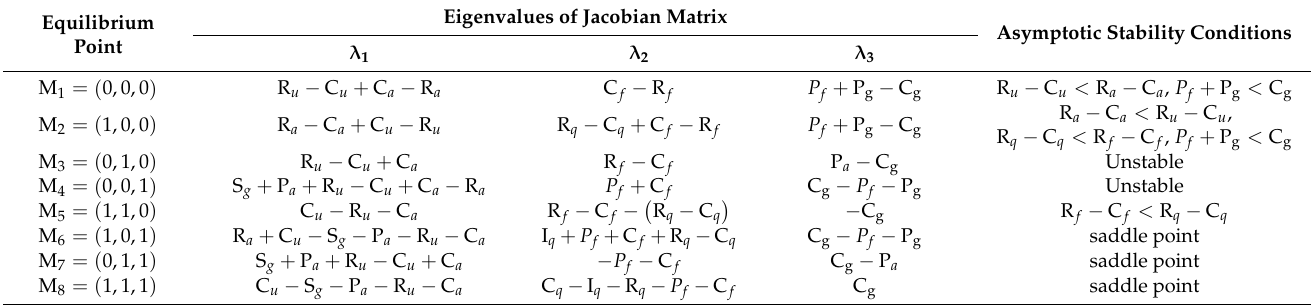
Table 2. Eigenvalues of Jacobian